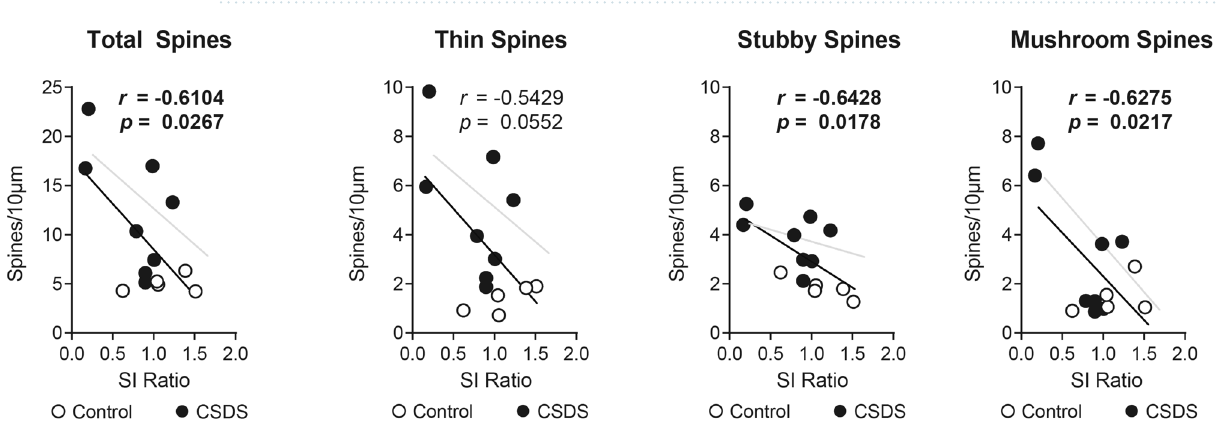
Figure 3. Correlations between social interaction behavior and spine density in control (white circles) and CSDS mice (black circles), and broken down by spine type. Black lines and inset R and P-values are the linear regression of both CSDS and control mice together. Gray lines are the regression of CSDS mice alone. SI Ratio is time spent in the interaction zone of a social interaction test with a novel target present divided by the time when novel target is